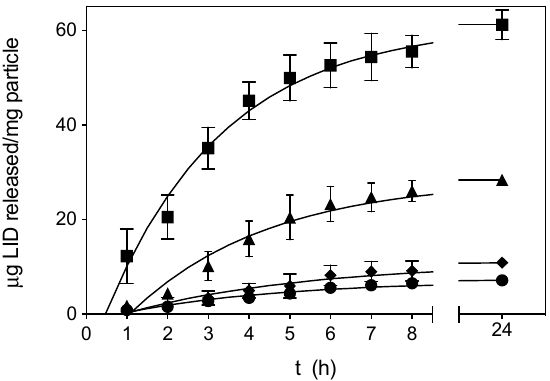
Figure 5. Figure 5. Release data of GMS-LID1 (circles), GMS-LID2 (diamonds), GMS-LID4 (triangles), and and GMS-LID10 (squares) particles in PBS pH 7.4 at 37 ◦ C and 100 rpm. Lines represent the GMS-LID10 (squares) particles in PBS pH 7.4 at 37 °C and 100 rpm. Lines represent the fittings to a fittings to a first-order kinetic release with lag time model (Equation first-order kinetic release with lag time model (Equation (3)).